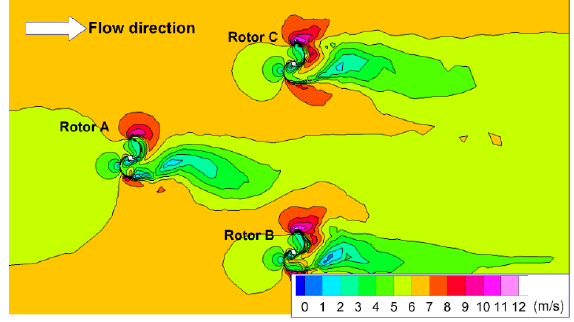
Figure 13. Three-rotor scheme and corresponding velocity distributions.